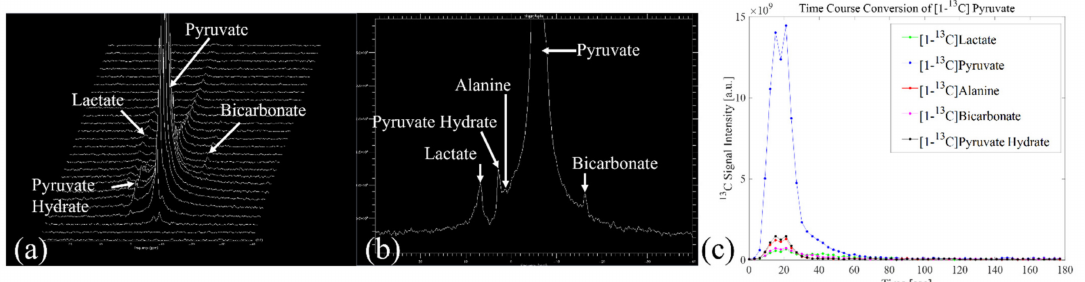
Figure 7. Slab dynamic 13 C MR spectra of swine cardiac with respect to time. Stacked [1- 13 C] spectra in ( a ) are acquired 60 times every 3 s. The spectra of [1- 13 C] pyruvate, [1- 13 C] lactate [1- 13 C] bicarbonate, and [1- 13 C] pyruvate hydrate are also acquired. Reconstructed summed [1- 13 C] spectra in ( b ) and signal intensity graphs in ( c ) demonstrate the time course of conversion of [1- 13 C] pyruvate, [1- 13 C] lactate [1- 13 C] bicarbonate, [1- 13 C] pyruvate hydrate, and [1- 13 C]